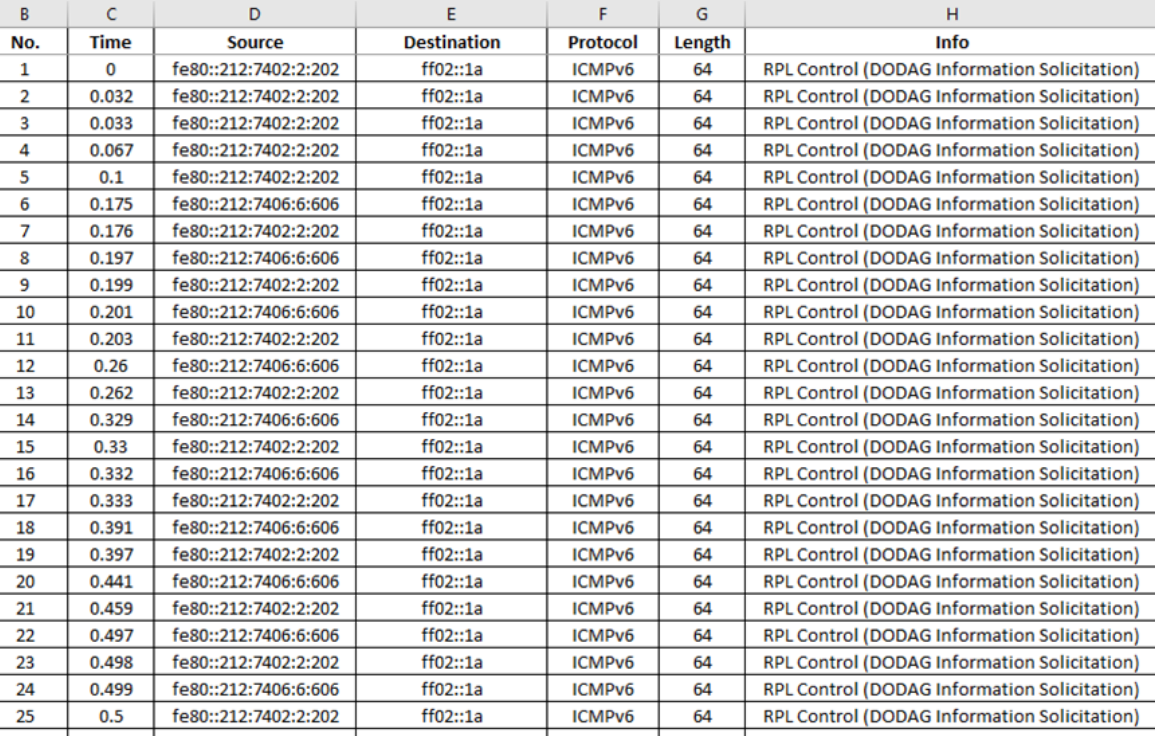
Figure 35. Malicious “radiologICMPv6.csv”— 1 to 25 records.